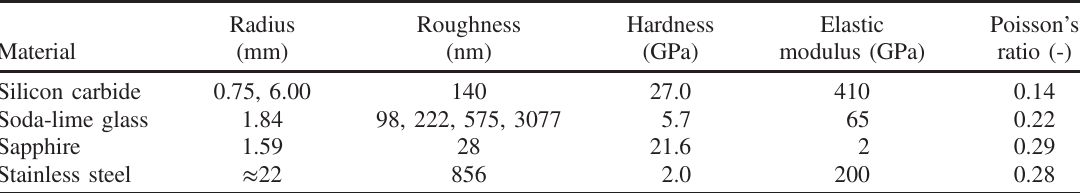
TABLE I. Mechanical and geometrical details of the sliders used in the friction experiments. Material